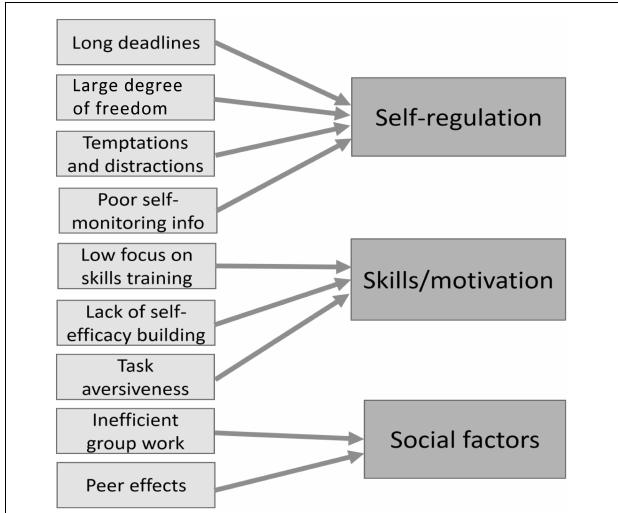
FIGURE 1 | How procrastination-friendly factors relate to important themes in